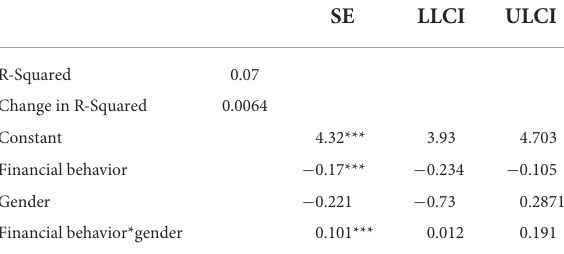
TABLE 6 Moderation of gender between financial behavior and COVID-19 distress.